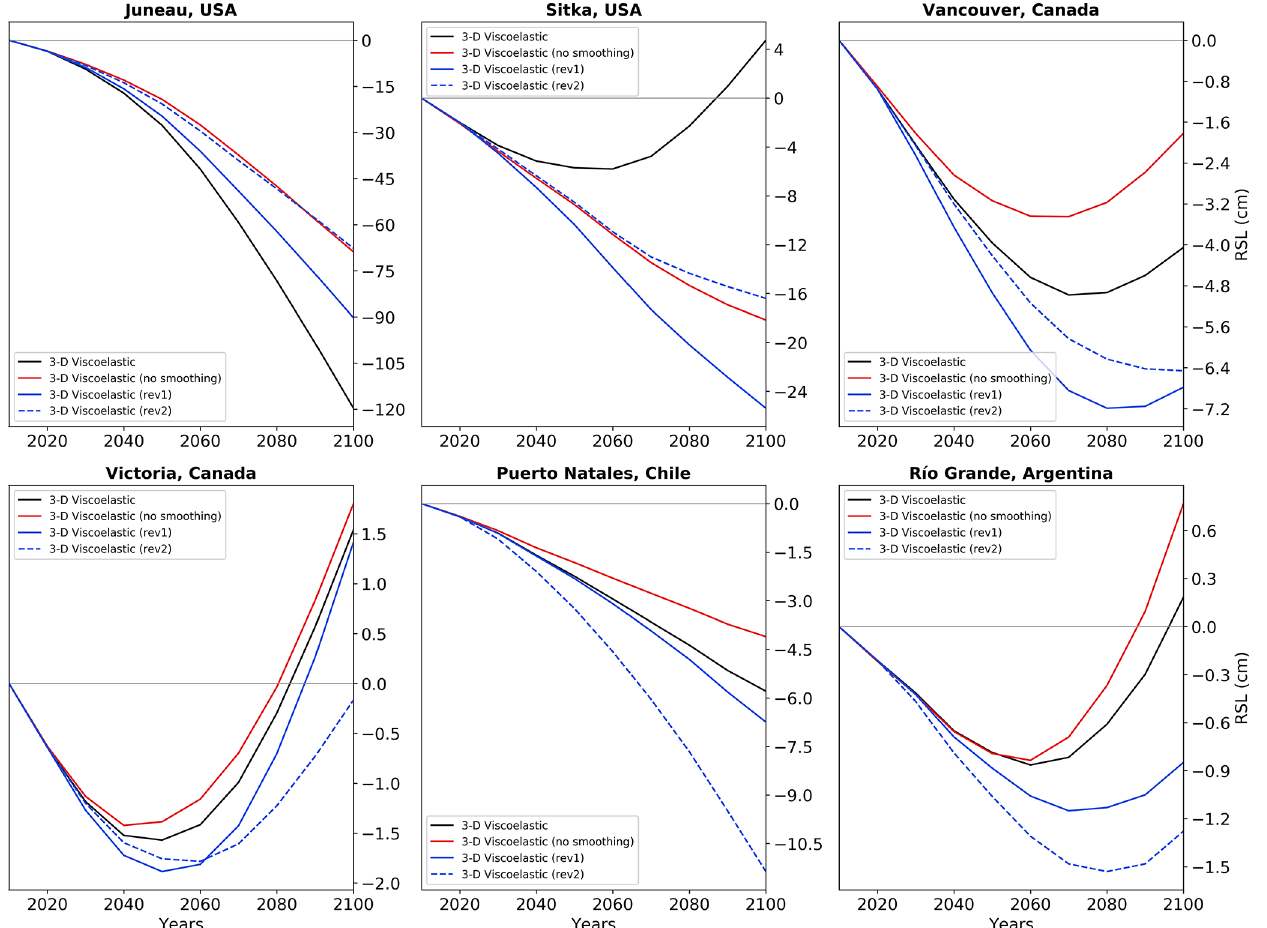
Figure 6. Calculated RSL curves showing the sensitivity of model output to changes in input parameters. The 3D viscoelastic results (black lines) are calculated using the same model parameters used to determine the results shown in Figs. 4 and 5. The coloured lines in each frame show the influence of changing the regional ice model (red line) or two different aspects of the regional Earth viscosity model (blue lines). As for Fig. 5, these results do not include the sea-level signal associated with ice mass changes from outside the respective RGI